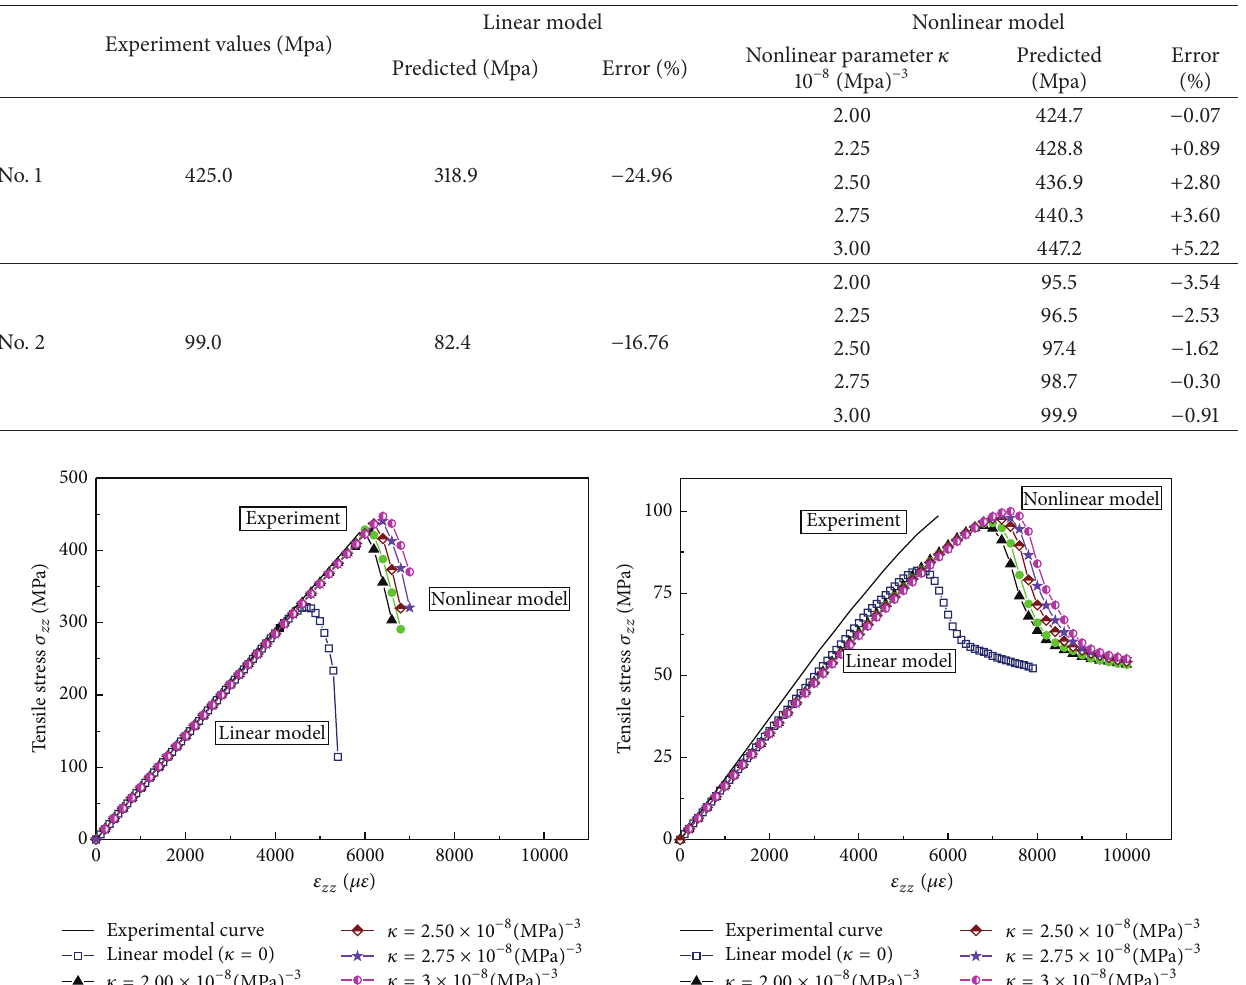
Table 4: Comparison of experiment data with predicted strength.